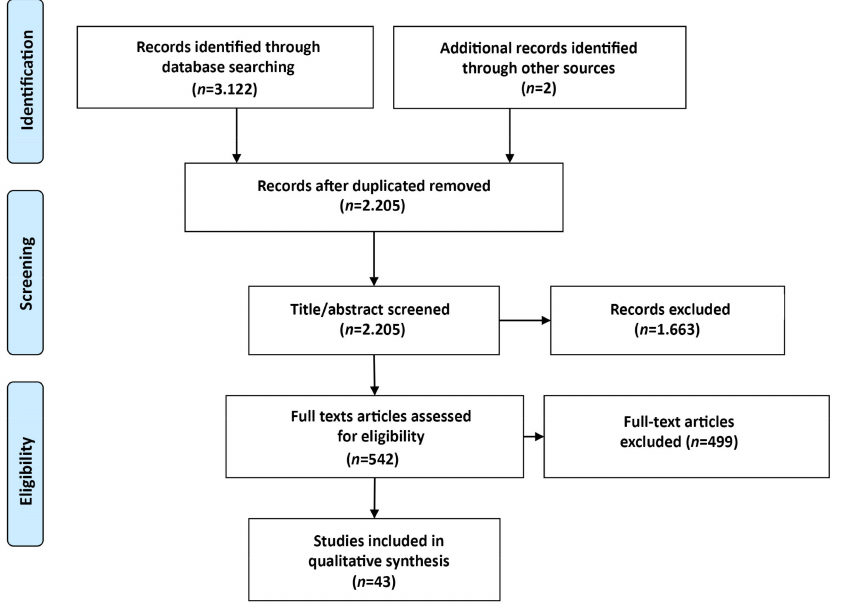
Figure 1. Flowchart of study selection process.